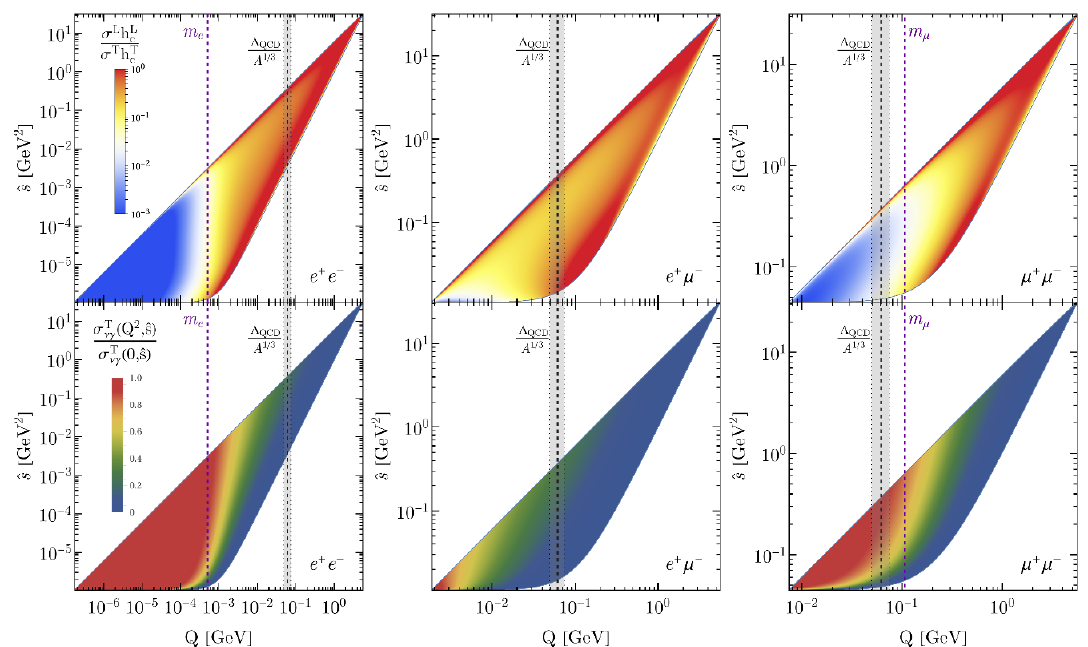
Figure 4 . Comparison between the full calculation of the trident production coherent cross section and the EPA in the kinematically allowed region of the ( Q; ^ s ) plane for an incoming (cid:23) (cid:22) with (cid:12)xed energy E (cid:23) = 3 GeV colliding with an 40 Ar target. The left, middle and right panels correspond to the dielectron, mixed and dimuon (cid:12)nal-states, respectively. The top panels correspond to the comparison between the longitudinal and transverse contributions while the bottom ones show the ratio between the transverse cross sections computed for an speci(cid:12)c value of Q with the cross section for an on-shell photon. The thick black dashed lines correspond to the cut in the Q 2 integration at (cid:3) 2 =A 2 = 3 , and the shadowed region around these lines account for a variation of 20% in the QCD value of this cut. The purple dashed lines are for Q = m (cid:11) , (cid:11) = e; (cid:22) for the unmixed